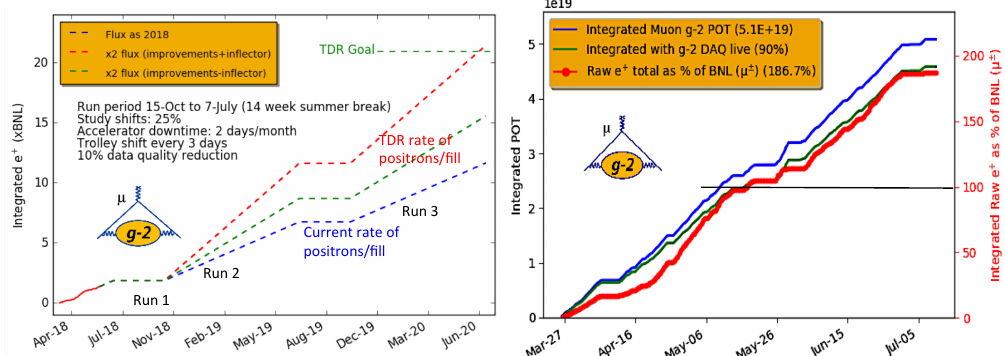
Figure 11. ( Left ) The accumulated statistics of integrated positrons with future projections; and ( Right ) the accumulated statistics of POT (protons on target) in blue and the raw number of positrons in red for Run